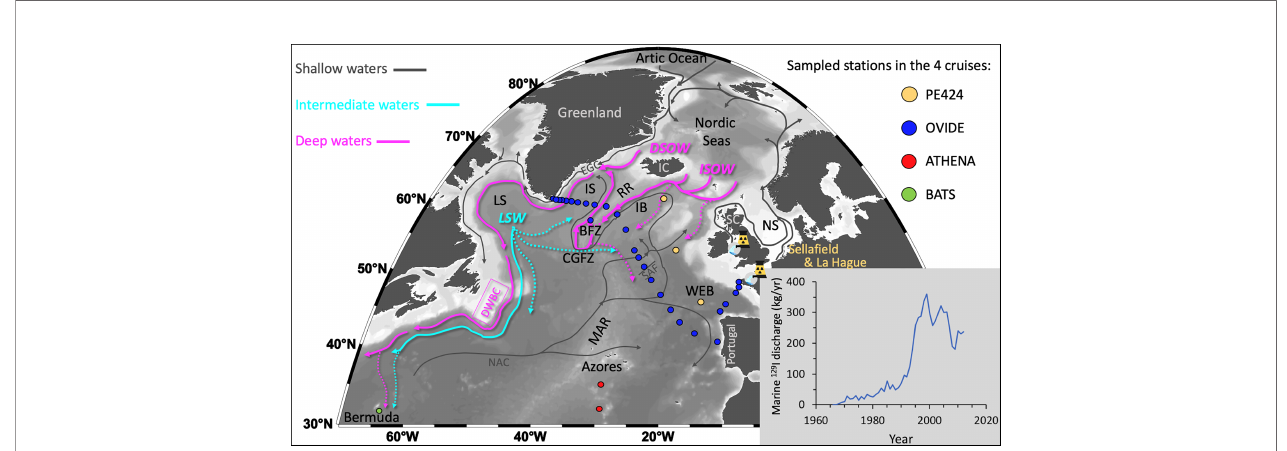
FIGURE 1 | Sampling sites during the four cruises (PE424, OVIDE, ATHENA and BATS), the combined 129 I marine discharge from the nuclear reprocessing plants of Sella fi eld and La Hague since the 1960s until the recent past (e.g. OSPAR, 2015; UK Environmental Agency, 2015), and the schematic circulation adapted from Daniault et al. (2016) to highlight boundary (solid lines) and interior (dotted lines) pathways of ISOW, LSW and DSOW. Acronyms in fi gure: Bight Fracture Zone, (BFZ); Charlie – Gibbs Fracture Zone, (CGFZ); Denmark Strait Over fl ow Water, (DSOW); Deep Western Boundary Current, (DWBC); East Greenland Current, (EGC); Iceland Basin, (IB); Iceland, (IC); Iceland Scotland Over fl ow Water, (ISOW); Irminger Sea, (IS); Labrador Sea, (LS); Labrador Sea Water, (LSW); Mid Atlantic Ridge, (MAR); North Atlantic Current, (NAC); North Sea, (NS); Reykjanes Ridge, (RR); Sub-Arctic Front, (SAF); Scotland, (SC); and West European Basin,